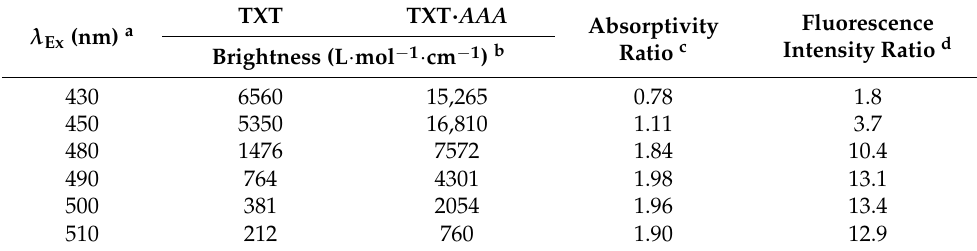
Figure 6. Absorbance (dashed) and fluorescence (solid) observables of TXT and TXT • AAA (488-nm excitation). Table 3. Spectroscopic properties of TXT labeled with AlMF